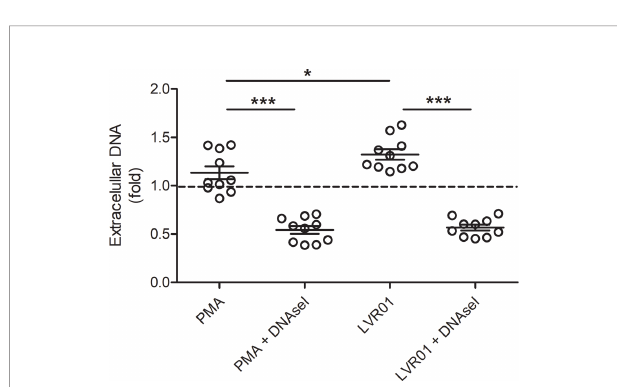
FIGURE 3 | Extracellular DNA quanti fi cation. Cells were incubated for 30 minutes with PMA or LVR01, with or without DNAse I pretreatment. DNA quanti fi cation was assessed with PicoGreen reagent. The dashed line indicates mean value of untreated cells. Results are shown as fold increase of individual replicates (n = 10) and mean ± SD for each evaluated condition. *p ≤ 0.05 and ***p ≤ 0.001, Student T-test. One representative experiment